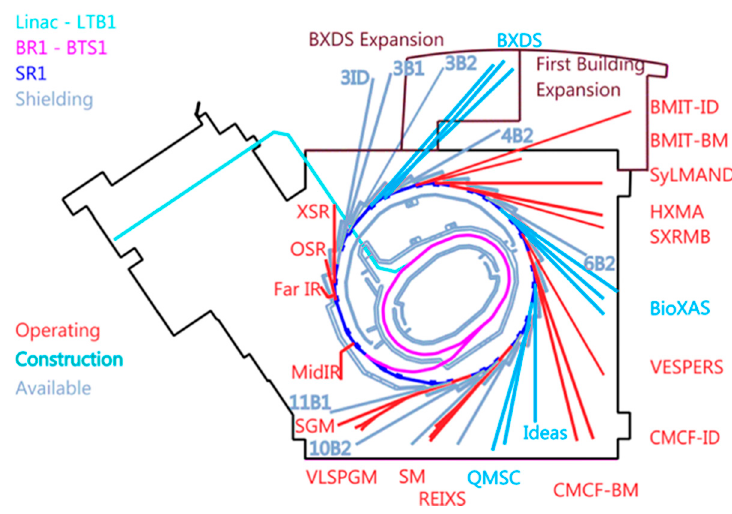
Figure 1. Schematic layout of the experimental hall at the Canadian Light Source (CLS).